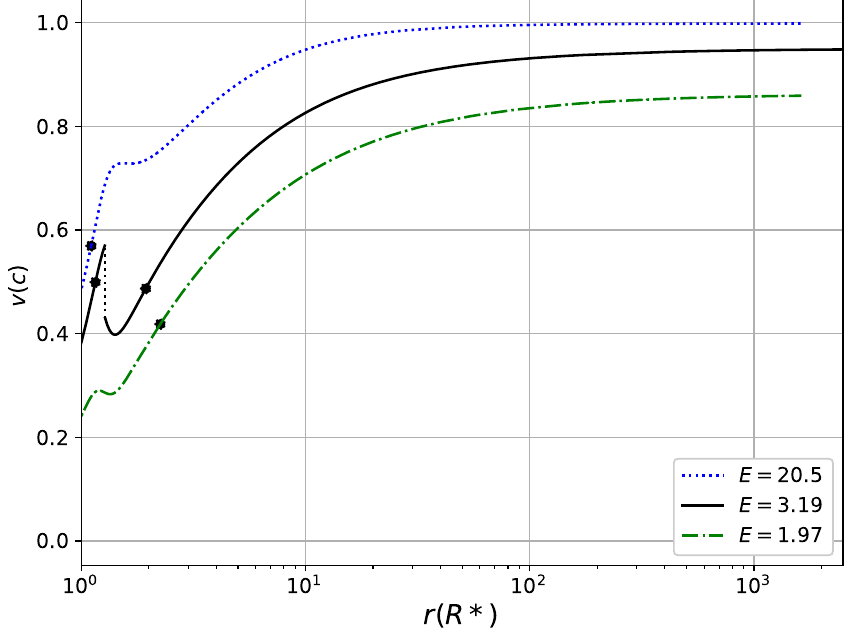
Figure 5. Velocity profiles for m = 0.3 with different values of E = 20.5 (dotted blue), 3.19 (solid black) and 1.97 (dashed–dotted green). The vertical dotted line marks the shock transition at location r = 1.275 R ∗ and filled circles denote the sonic points through which the physical solutions